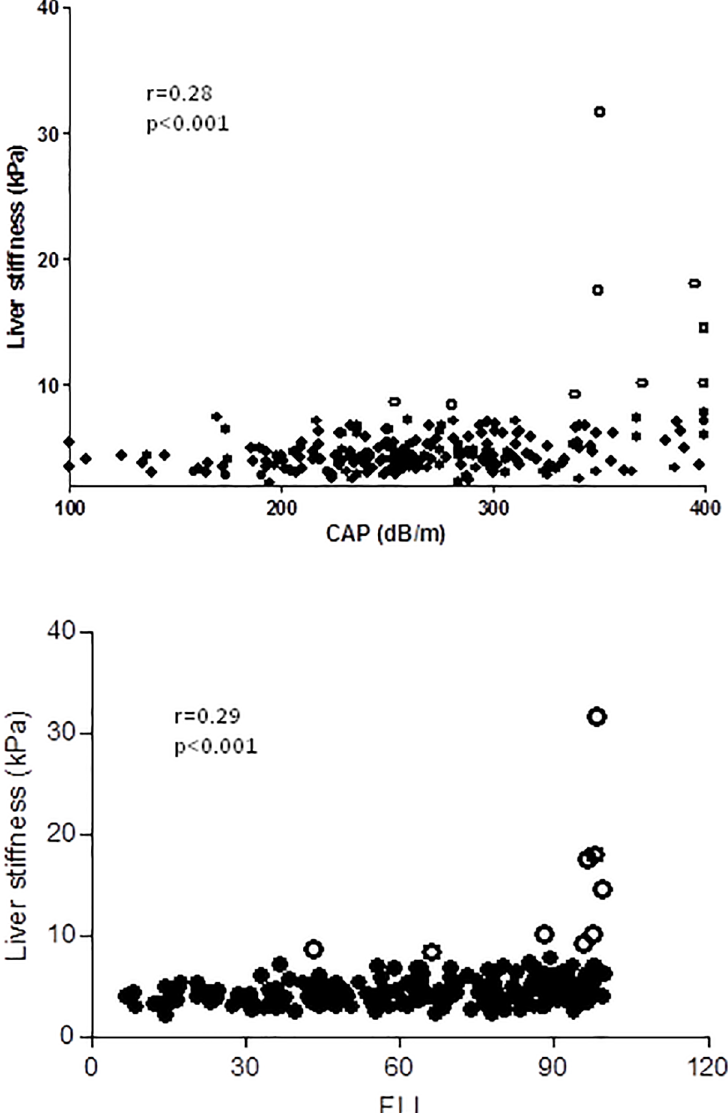
Fig 5. (upper panel) Relationship between liver stiffness and CAP values in patients with risk factors for NAFLD. (lower panel) Relationship between liver stiffness and FLI values in patients with risk factors of NAFLD. Empty circles represent patients with liver stiffness greater than 8